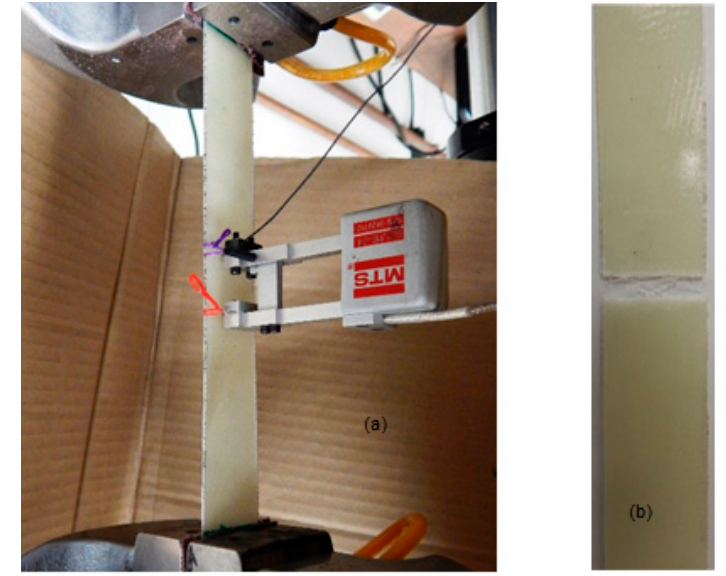
Figure 11. ( a ) Polyester surfacing veil coupon during the test and ( b ) damaged specimen after the